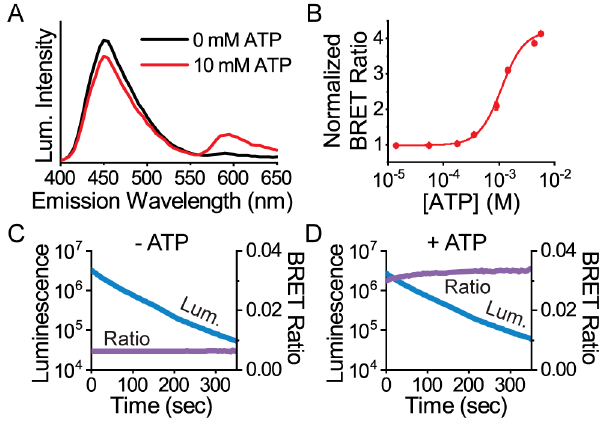
Figure 2. Protein characterization of the mScarlet- ε -NanoLuc sensor called ARSeNL (ATP detection with a Ratiometric mScarlet-NanoLuc sensor). ( A ) Luminescence emission spectra and ( B ) the ATP-dependent mScarlet/NanoLuc BRET ratio response (K D = 1.1 ± 0.1 mM, n = 3) were measured on a microplate reader, and data were fitted to the Hill equation. ( C,D ) The BRET ratio (purple) is stable